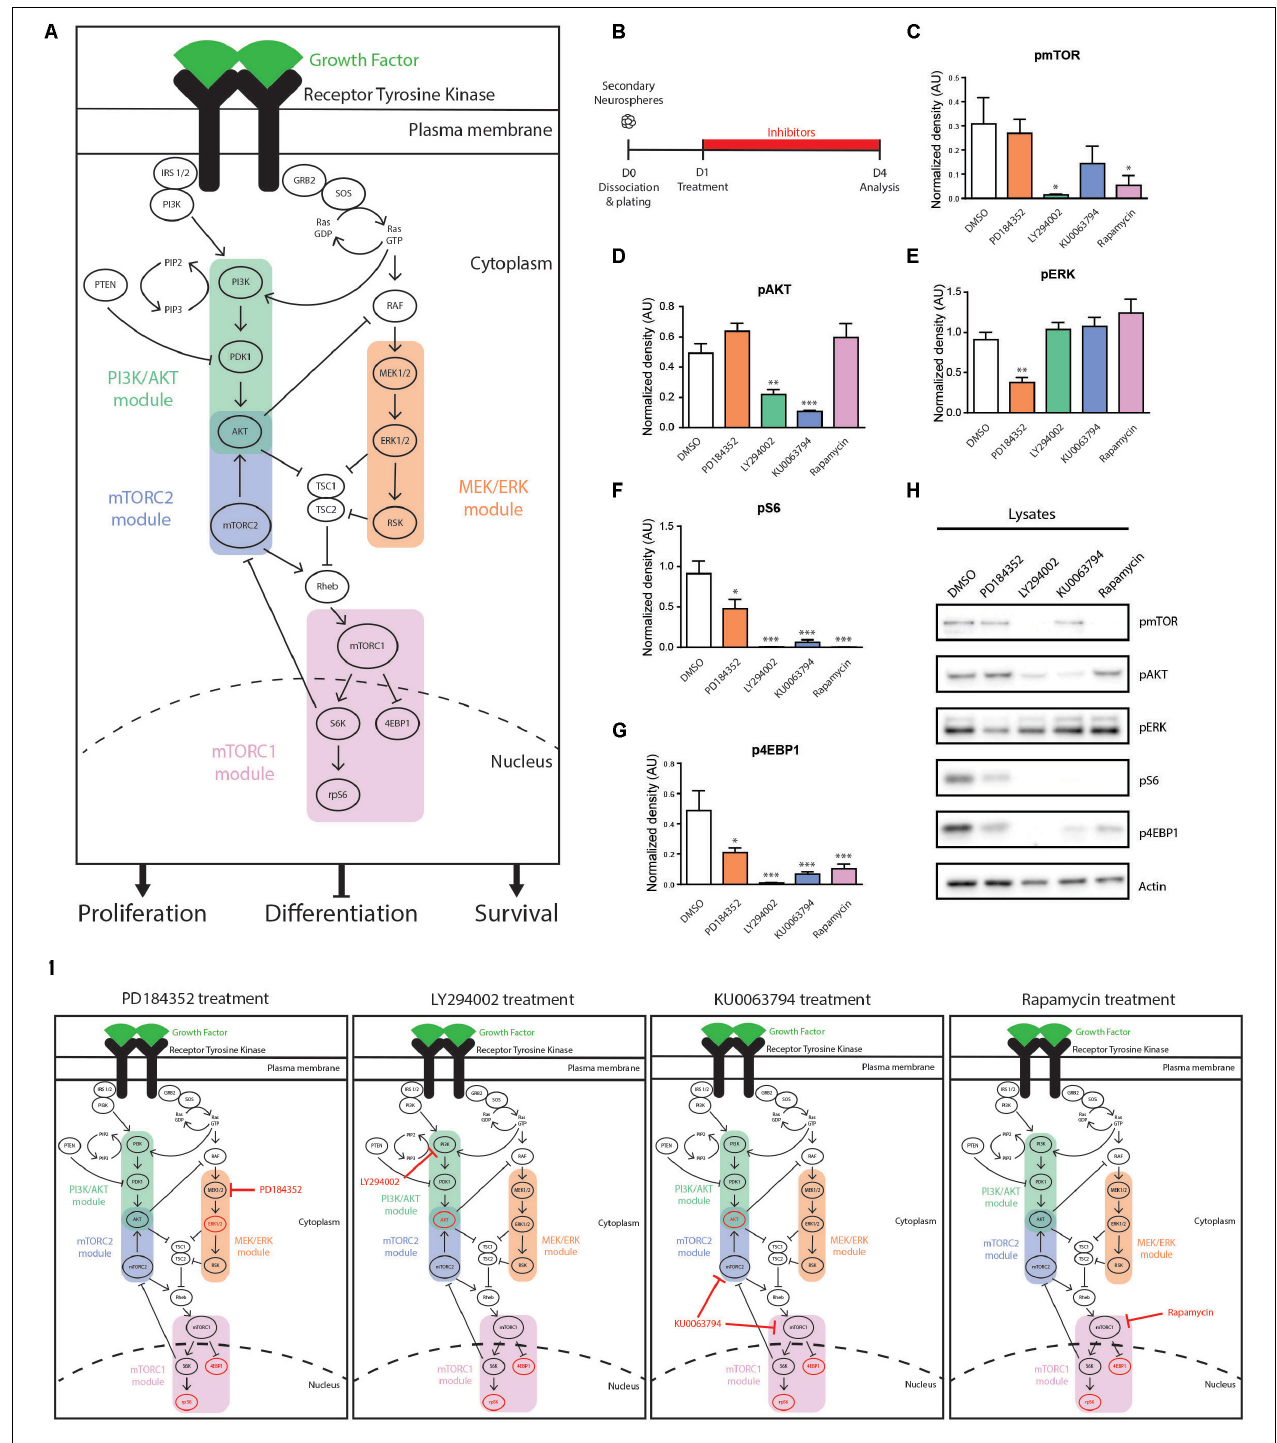
FIGURE 2 | Signaling modules influenced in cultured NSPCs by the pharmacological inhibitors PD184352, LY294002, KU0063794 and Rapamycin. (A) Schematic representation of the RTK-induced PI3K/AKT, MEK/ERK, mTORC1, and mTORC2 signaling modules. In NSPCs, activation of these pathways downstream of EGFR result in stimulation of NSPC proliferation and survival and inhibition of NSPC differentiation. (B–H) Effect of inhibitors on components of EGF-induced signaling pathways. (B) Paradigm. (C–G) Densitometric quantifications of the phosphorylated (p) proteins (C) pmTOR, (D) pAKT, (E) pERK, (F) pS6, and (G) p4EBP1, with (H) representative Western blots ( n = 3/group). One-way ANOVA with Dunnett’s post hoc test. (I) Summary of signaling modulations induced by each inhibitor. Signaling components with reduced phosphorylation are shown in red. ∗ p ≤ 0.05; ∗∗ p ≤ 0.01; ∗∗∗ p ≤ 0.001.